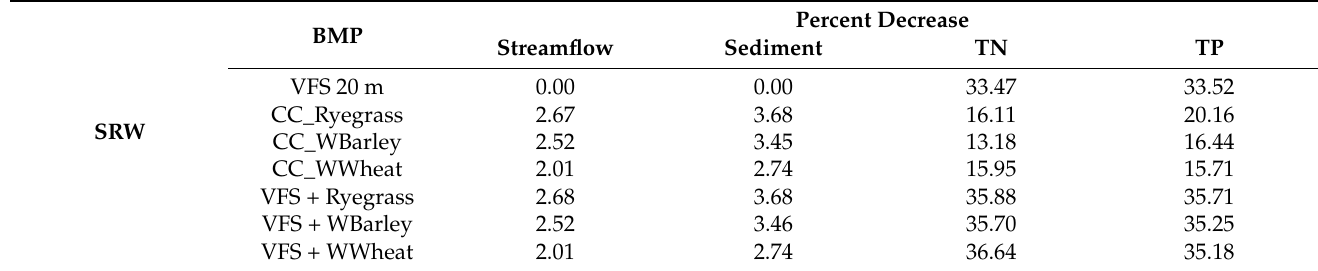
Table 5. Percentage reductions when different BMPs were implemented in